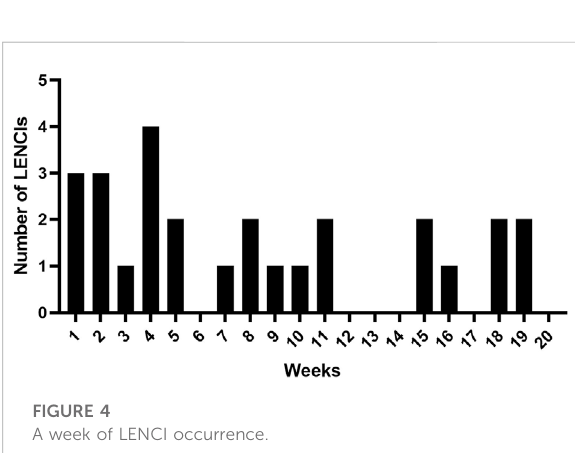
FIGURE 4 A week of LENCI